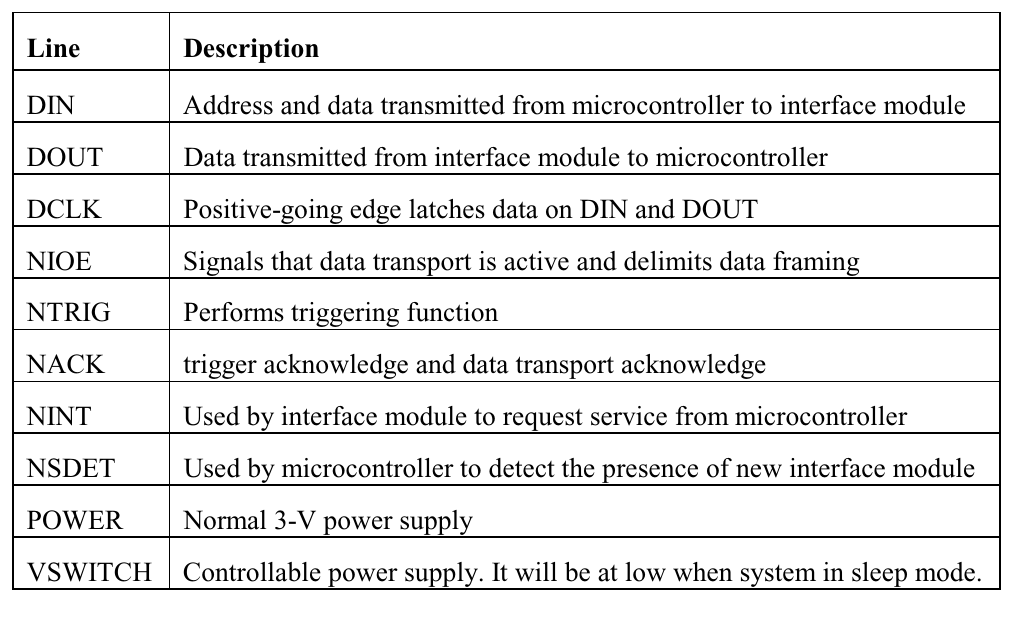
Table 1. IM2 bus